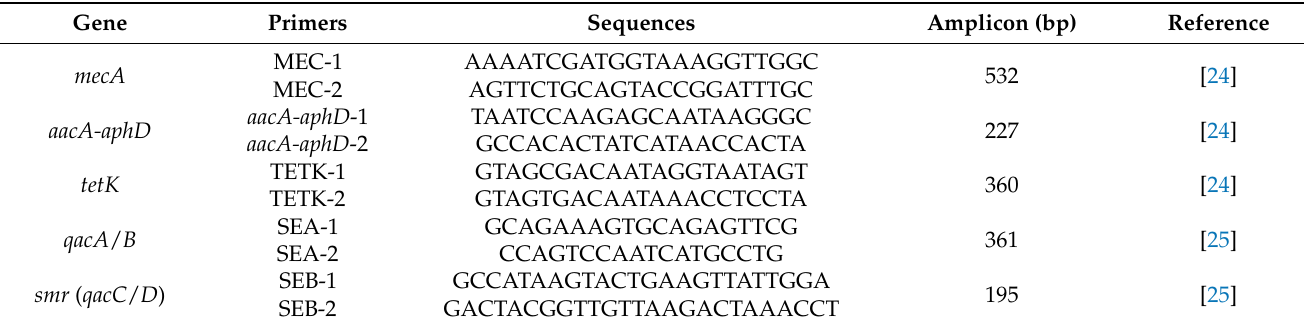
Table 1. Primers used in the investigation of antibiotic resistance and efflux pump